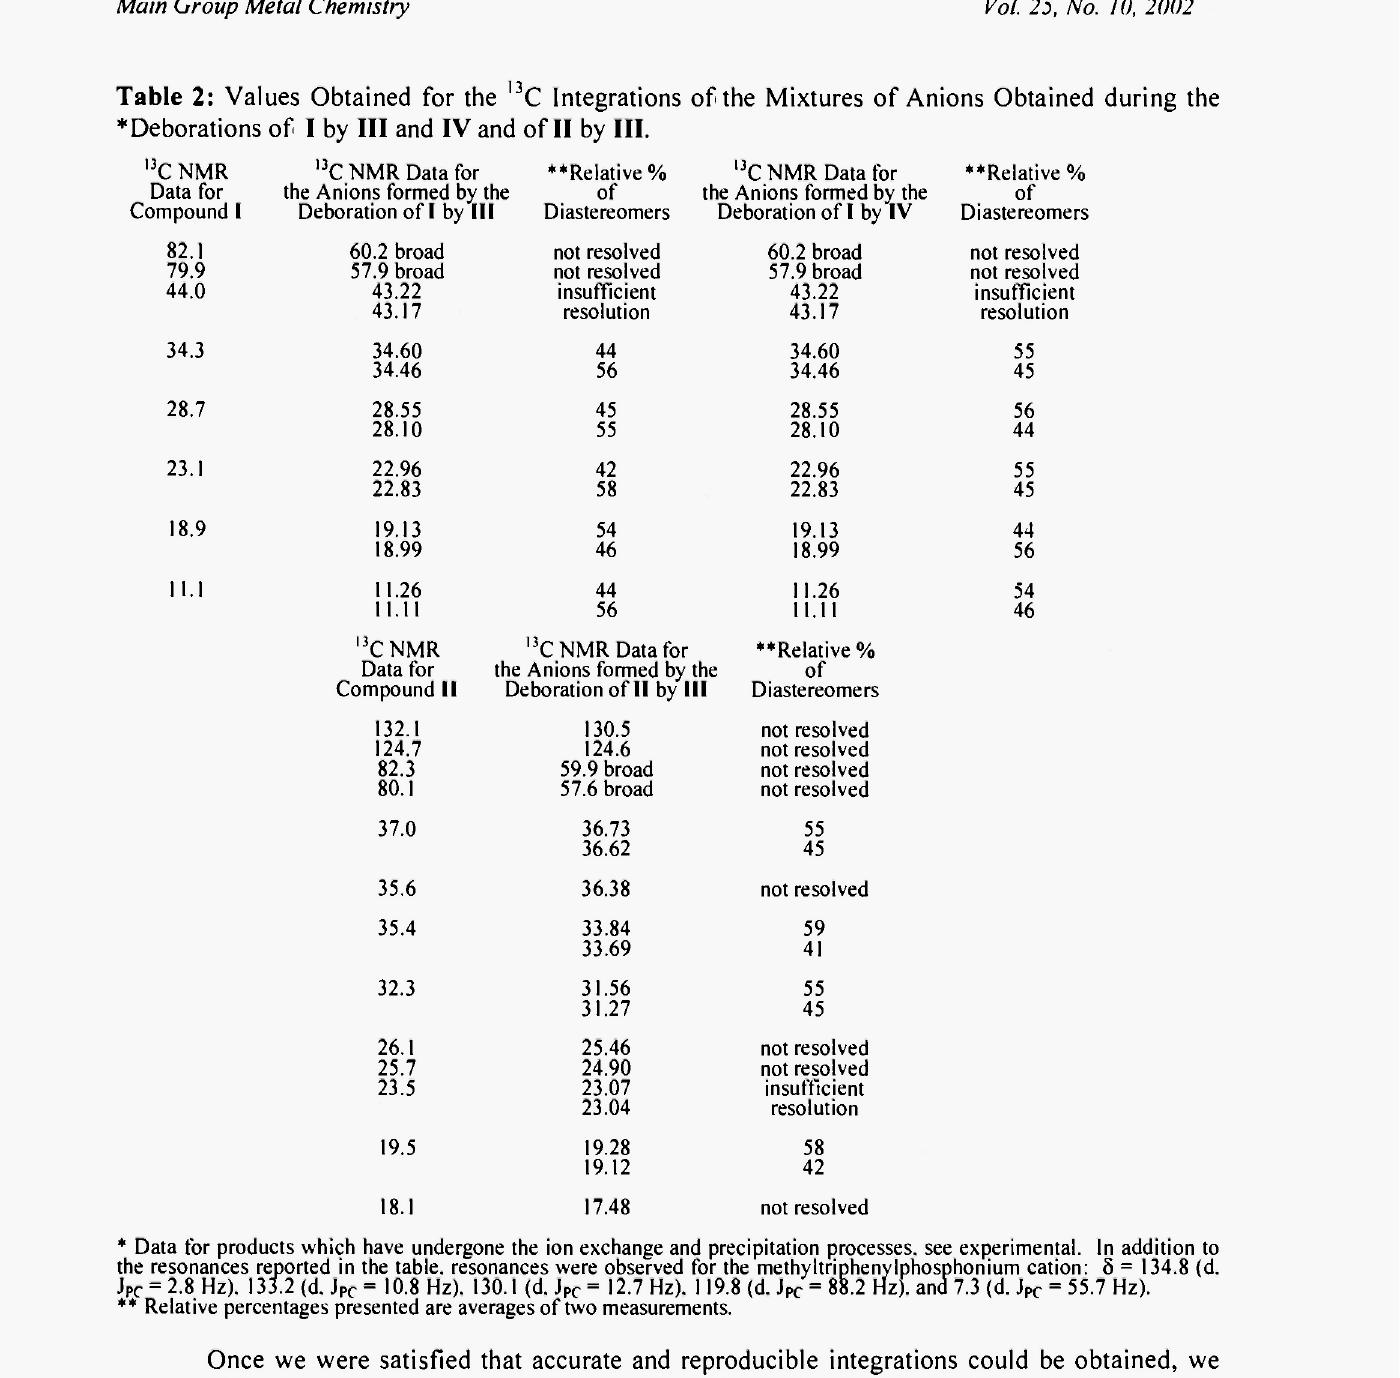
Table 2: Values Obtained for the i3 C Integrations of the Mixtures of Anions Obtained during the •Deborations of I by III and IV and of II by III. l3 CNMR Data